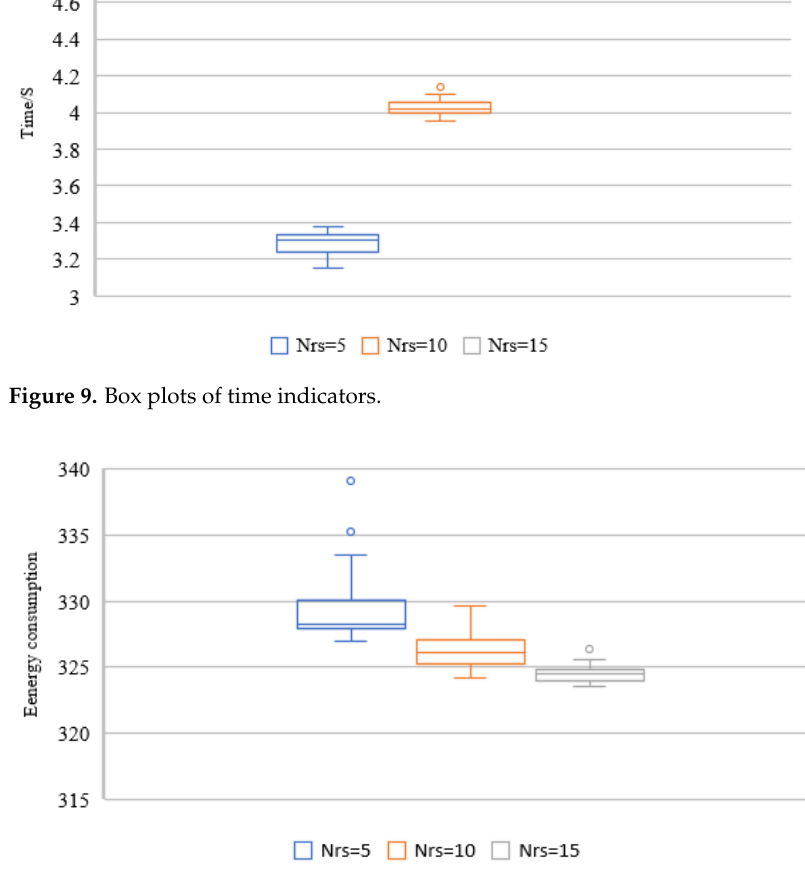
Figure 9. Box plots of time indicators.